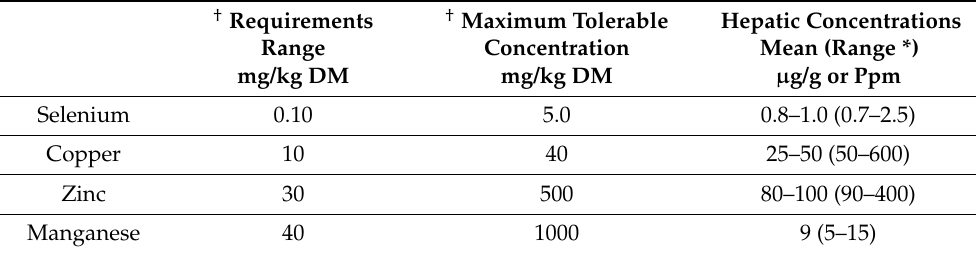
Table 1. Reference values of trace mineral requirements, maximum tolerable concentrations and hepatic concentrations in adults and growing